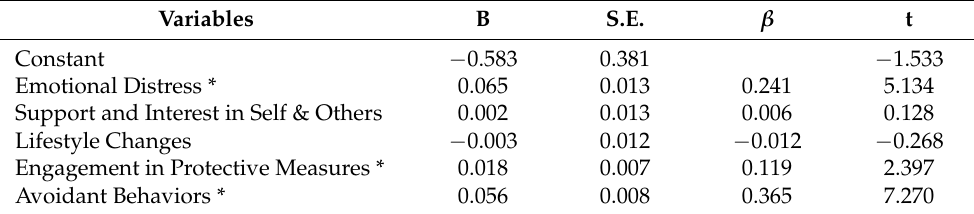
Table 2. Results of multiple regression analysis predicting the level of